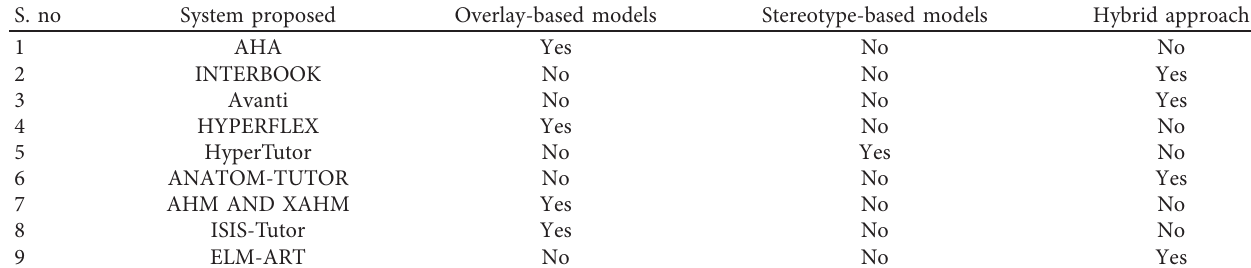
Table 3: Adaptive hypermedia system modeling